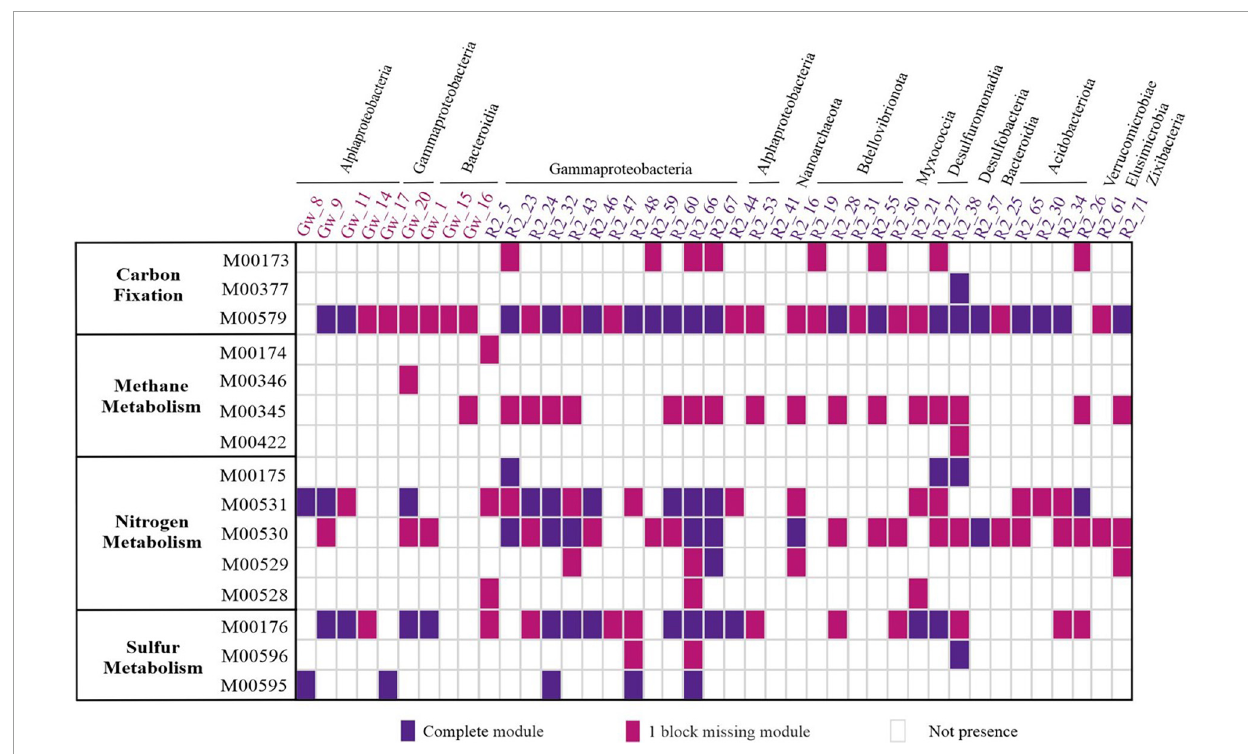
FIGURE5 Energy metabolism pathways modules present in recovered MAGs from the groundwater metagenomes. The columns represent the taxonomy recovered of MAGs. The color of each MAG indicates the MAG origin. The row shows the cluster of metabolic pathways. Reductive citrate cycle (Arnon–Buchanan cycle) (M00173), reductive acetyl-CoA pathway (Wood–Ljungdahl pathway) (M00377), and phosphate acetyltransferase-acetate kinase pathway (M00579). Methane oxidation, methanotroph (M00174), formaldehyde assimilation, serine pathway (M00346), formaldehyde assimilation, ribulose monophosphate pathway (M00345), and Acetyl-CoA pathway (M00422). Nitrogen fixation (M00175), assimilatory nitrate reduction (M00531), dissimilatory nitrate reduction (M00530), nitrification (M00528), and denitrification (M00529). Assimilatory sulfate reduction (M00176), dissimilatory sulfate reduction (M00596), and thiosulfate oxidation by SOX complex (M00595). For the presence of a module that has all the enzymes of a pathway the value 2 and for the module that lacks one of the enzymes of a pathway the value 1 is considered.